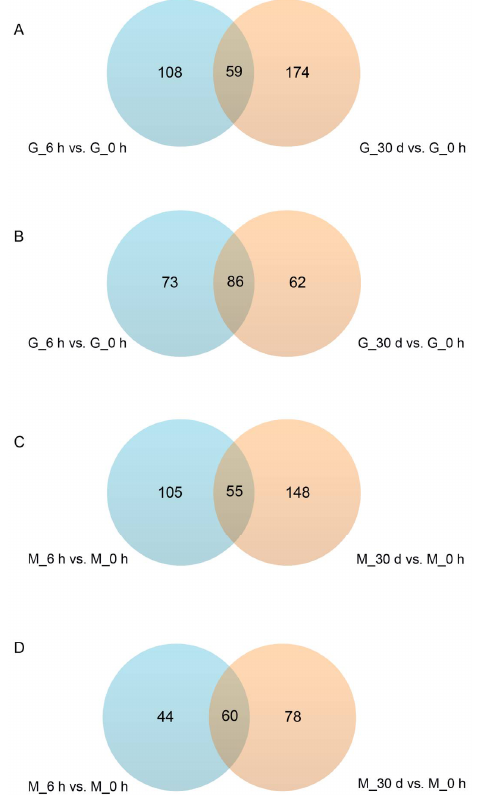
Figure 3. Significantly different metabolites (SDMs) in gill (G) and mantle (M) tissues of C. farreri subjected to heat stress for 6 h and 30 d are shown in the column chart. The orange columns represent the number of up-regulated SDMs, and the blue columns represent the number of down-regulated SDMs.